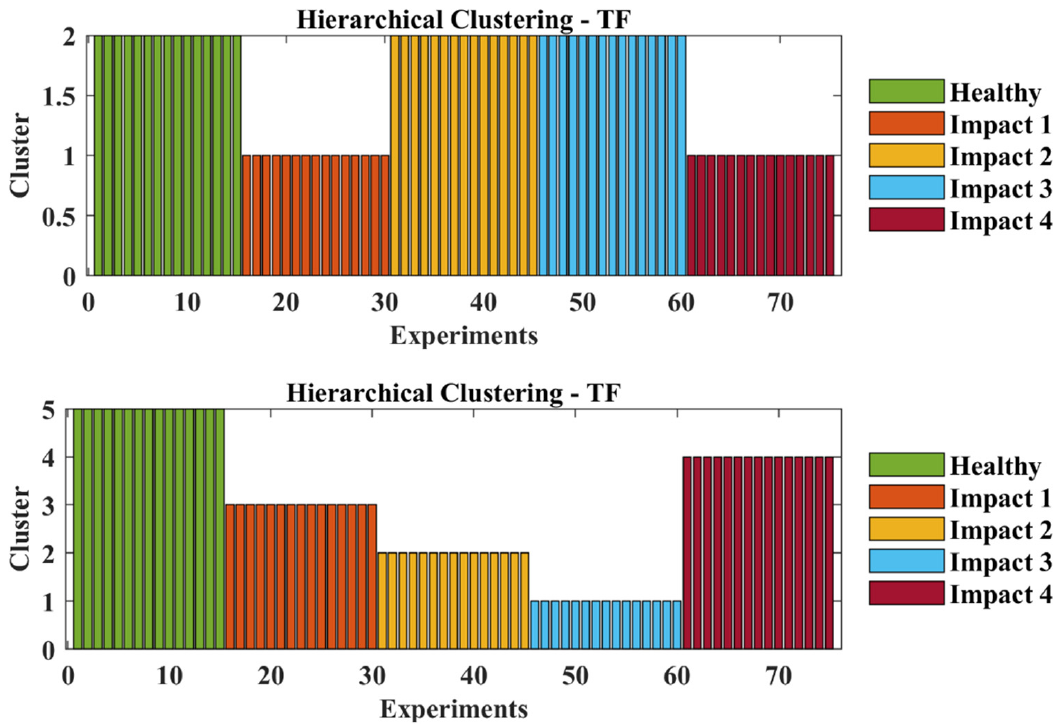
Figure 11. Hierarchical clustering using TF. Input cluster = 2 ( up ), input cluster = 5 ( down ).